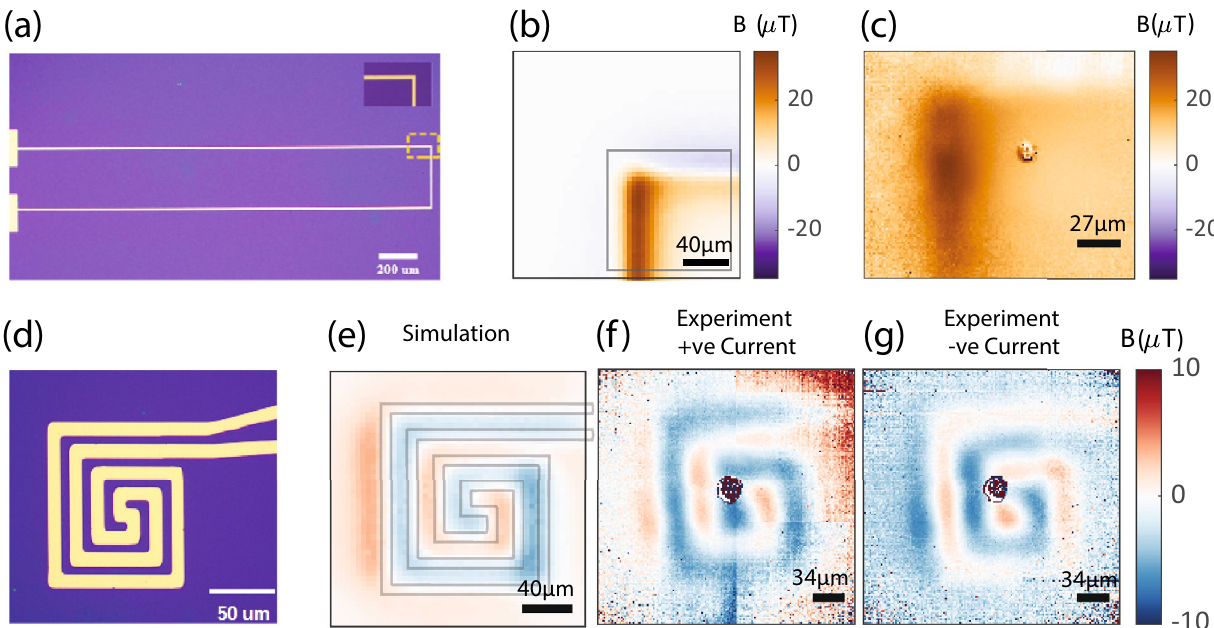
Figure 4. Static magnetic field images of the microwire and the microcoil sample: ( a ) color microscope image of the U shaped microwire sample. Microwire track width is 10 µ m . Scale Bar 200 µ m . Inset shows the 90 ◦ bend feature which has been imaged. ( b ) Simulation of single NV-axis magnetic field map of the 90 ◦ bend feature of the microwire, at a standoff 13 µ m and current 2.4 mA. Scale bar 40 µ m . Black square indicates the